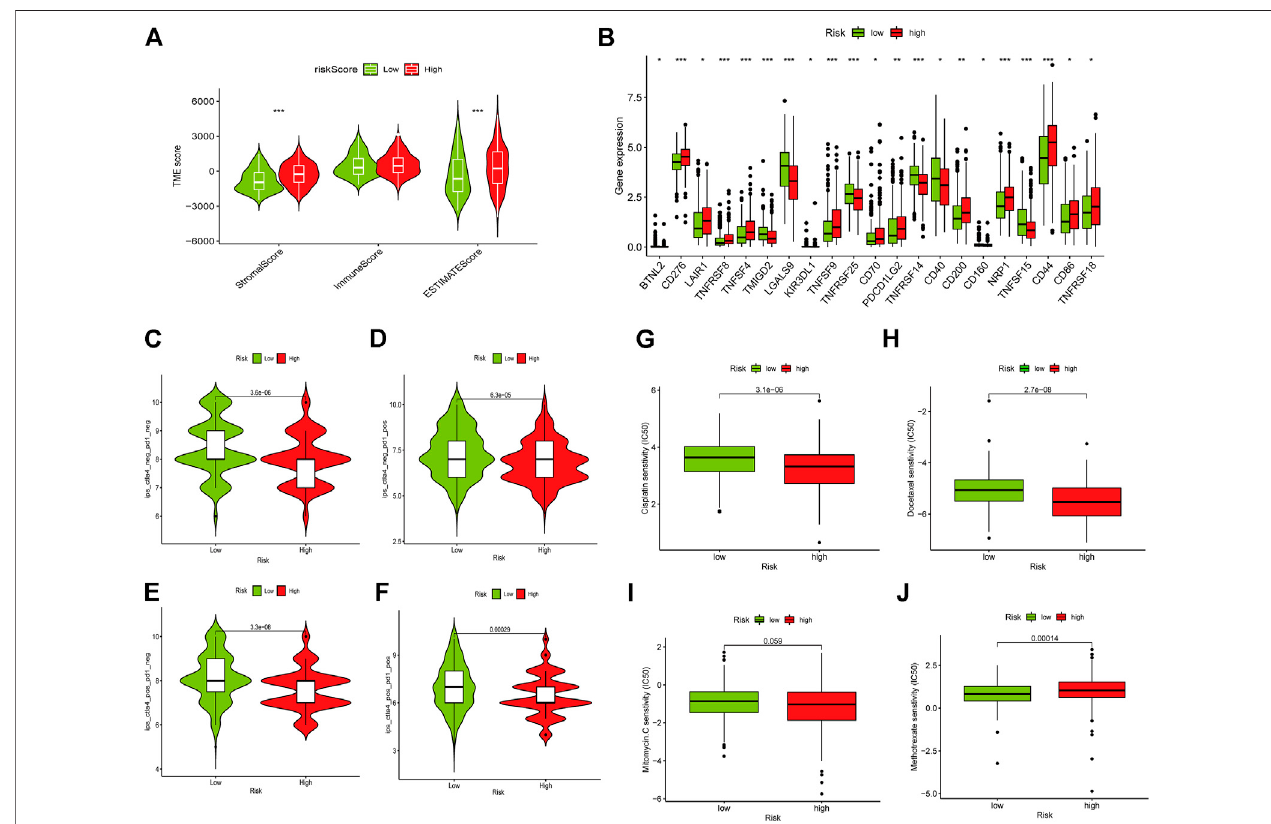
FIGURE8| Roleoftherisksignatureinimmunotherapeuticresponses. (A) ESTIMATEalgorithmwasusedtoinvestigatethecorrelationbetweenthetwogroupsin ImmunescoresandStromalscores.Someimmunecheckpointswereinvestigatedbetweenthetworiskgroups (B) . (C – F) Thecorrelationbetweenimmunophenoscore and different risk groups. Low risk subgroup was positively correlated with a higher IC50 of Cisplatin (G) , Docetaxel (H) , and Mitomycin C (I) , while a lower IC50 of Methotrexate (J) . * p < 0.05, ** p < 0.01,*** p < 0.001, ns p > 0.05.